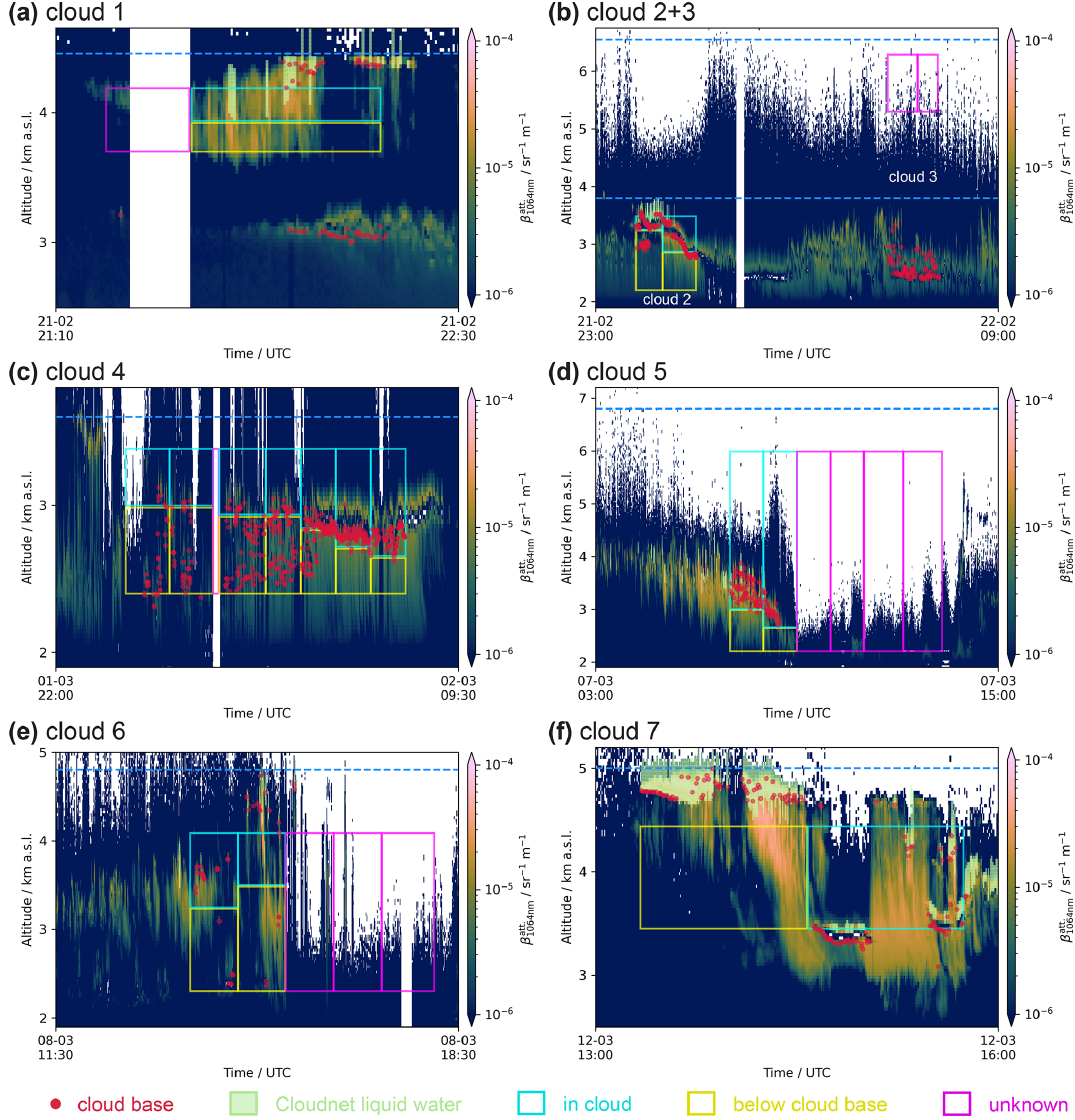
Figure C1. Time slicing and classification of the ice crystal number concentration data indicated in Fig. B1 (red rectangle encompasses rectangles presented in this plot). White background represents regions where the lidar either was fully attenuated or underwent automatic maintenance. The attenuated backscatter coefficient at 1064nm ( β att . ) is presented in the background. A (liquid) cloud base estimate 1064nm derived from the attenuated backscatter coefficient at 532nm ( β att . ) is indicated by red circles. The automated liquid water classification 532nm by the Cloudnet algorithm is presented by lime tiles. Empty rectangles in cyan, yellow, and magenta indicate regions classified as above cloud base, below cloud base, and unknown cloud base, respectively. Cloud top derived from radar observations (Fig. B1) is indicated by the dashed blue line. The dotted light blue line in (d) indicates the height above which homogeneous freezing is possible ( T < − 38 ◦ C).